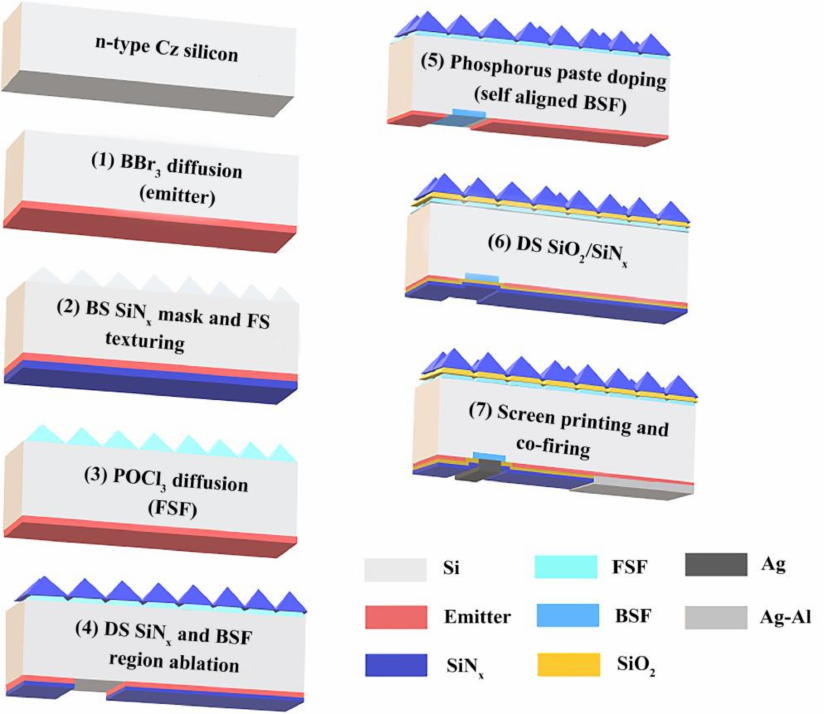
Figure 2. The process flow for fabricating the presented low-cost, industrially feasible IBC solar cell with laser ablation and screen printing. BS, FS and DS represent back side, front side and double sides respectively. FSF and BSF denote front surface field and back surface field